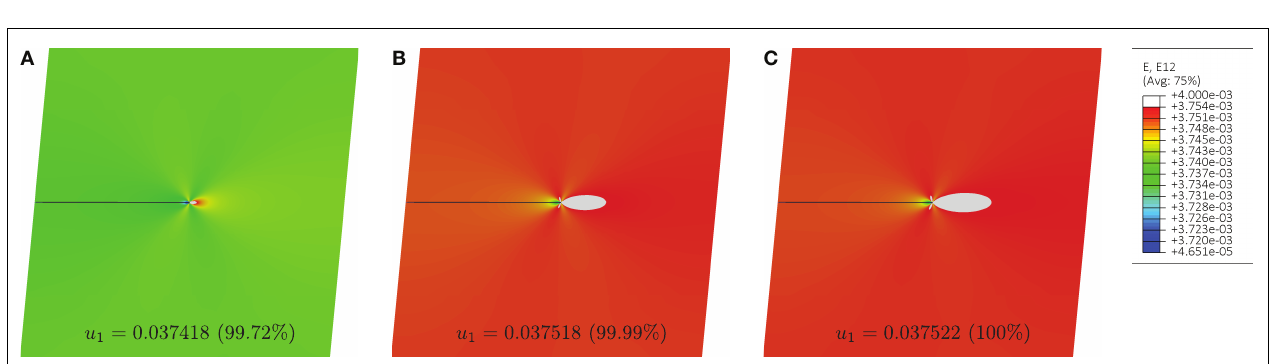
displacement at the upper edge of the square domain u 1 = 0.037418mm (A) , u 1 = 0.037518mm (B) , u 1 = 0.037522mm (C) .The displacements in the figures are amplified by a deformation scale factor of 25.